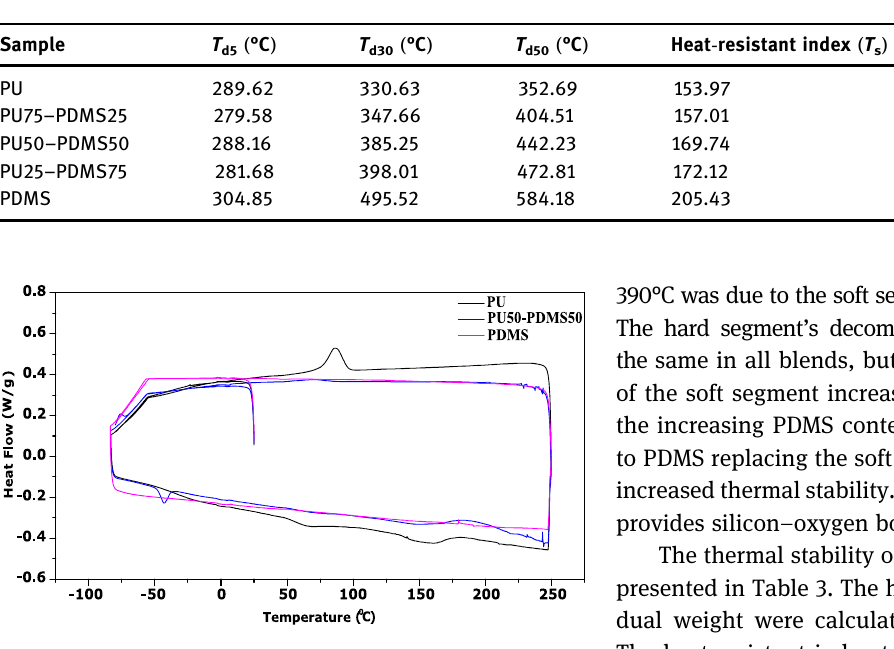
Table 3: Thermal stability of PU – PDMS polymer blends